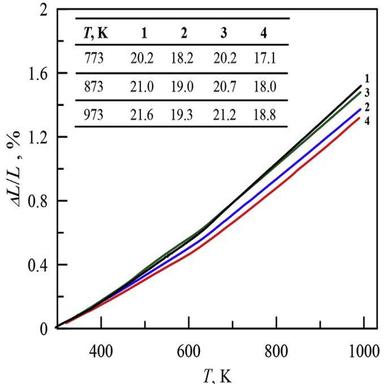
The temperature dependent linear elongation for ceramics of pure PYBC (1) and 70/30 wt% mixture of PYBC with SDC (2) in comparison with the elongation for pure PYBCN (3) and 70/30 wt% mixture of PYBCN with SDC (4). TEC values (a\$106 K1 ) for selected temperatures are summarized in the inset.